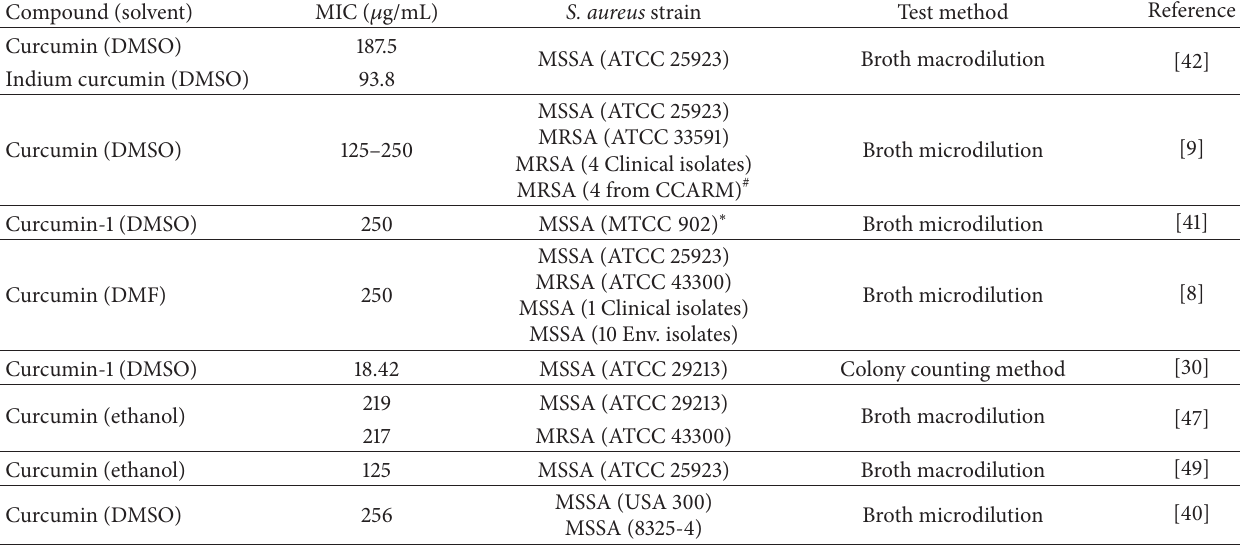
Table 1: Antibacterial activity of curcumin against S.